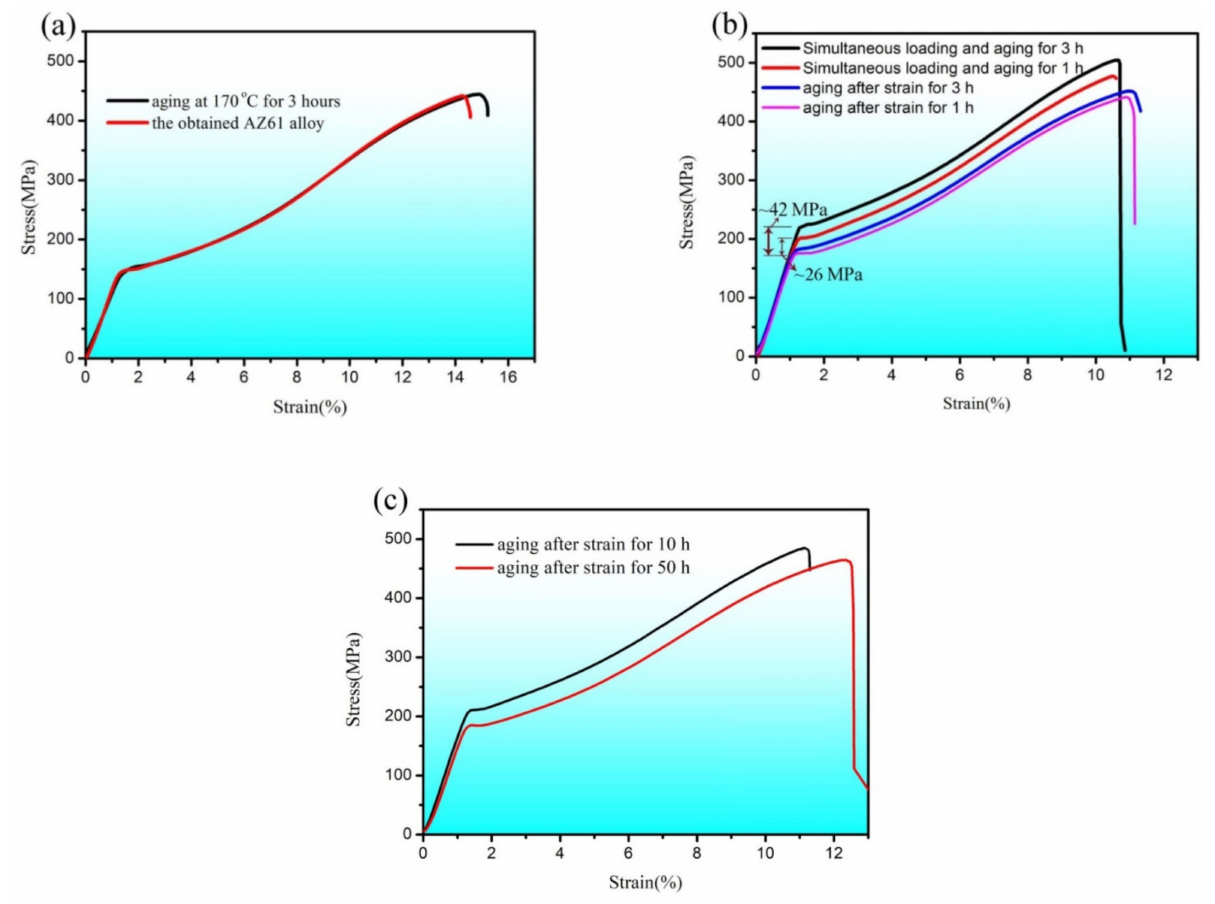
Figure 7. The stress–strain curves of the as-received AZ61 alloy and samples subjected to different heating and loading conditions. ( a ) the as-received alloy with and without aging; ( b ) samples subjected to aging after strain for 1 h and 3 h and simultaneous loading and aging for 1 h and 3 h respectively; ( c ) samples subjected to aging after strain for 10 h and 50